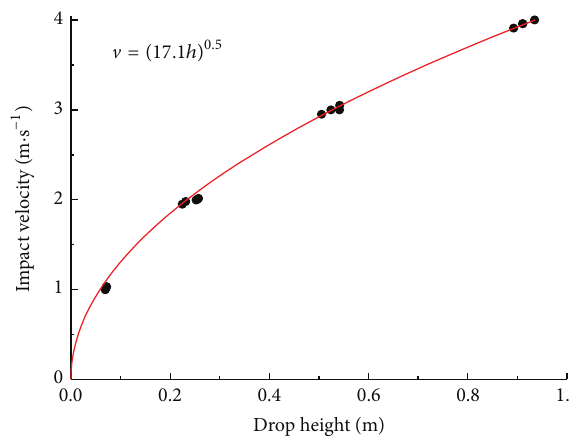
Figure 9: Relation between drop height and impact velocity.